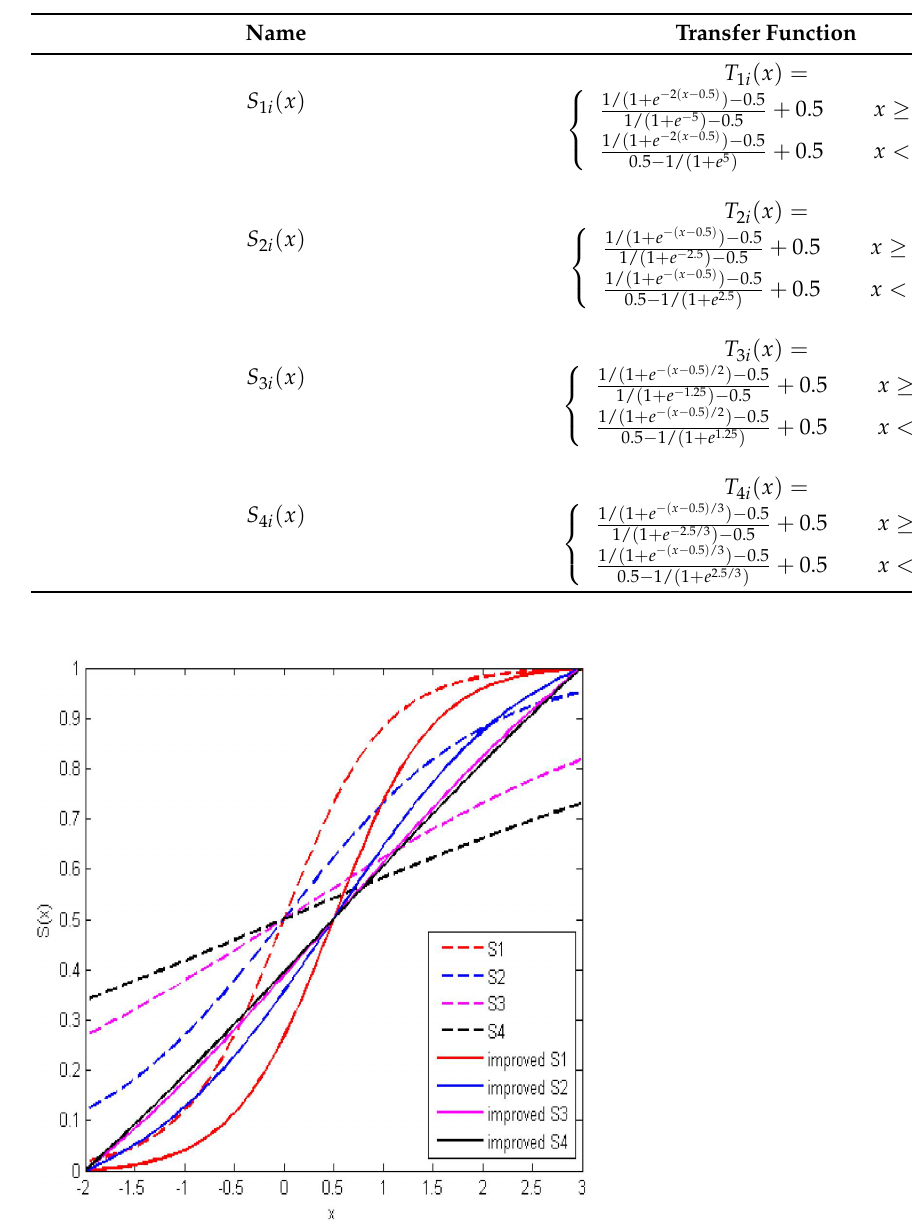
Table 6. The expressions of the improved S-shaped transfer functions.